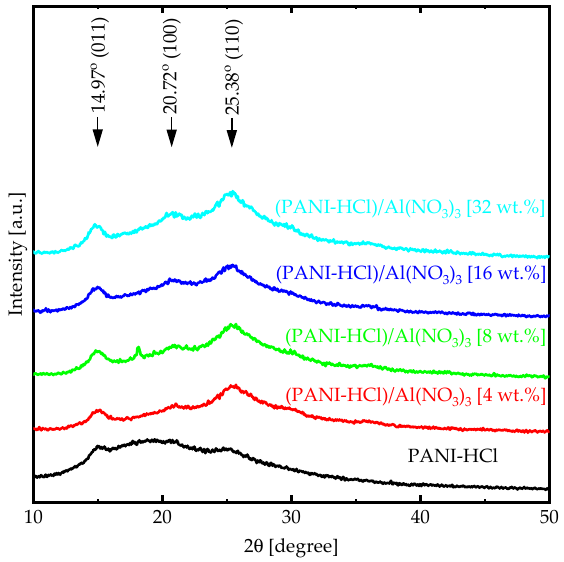
Figure 2. XRD patterns for (PANI-HCl)/Al(NO 3 ) 3 complex composite films for varying Al(NO 3 ) 3 concentrations (wt.%).